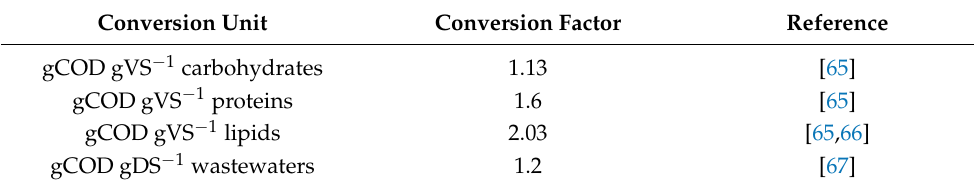
Table 1. Conversion factors used in this